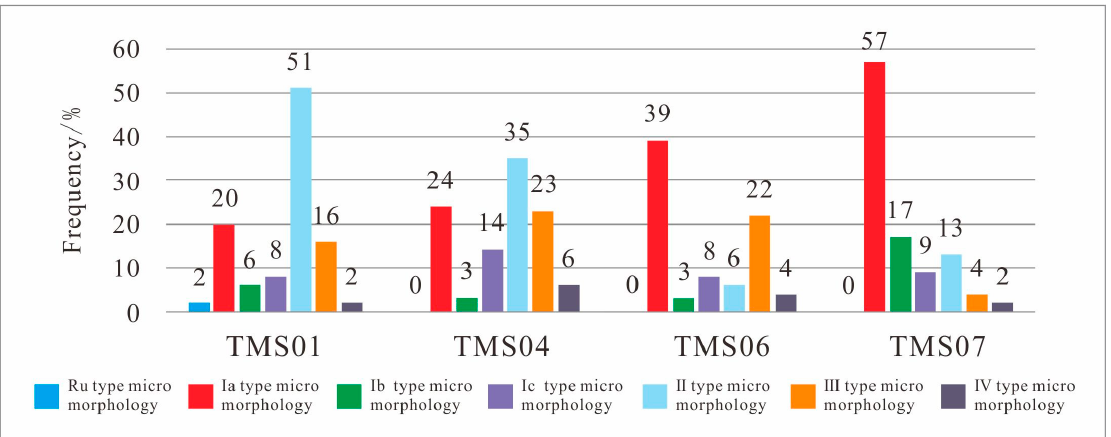
Figure 5. Classification and frequency of micro morphology of quartz grains in fault